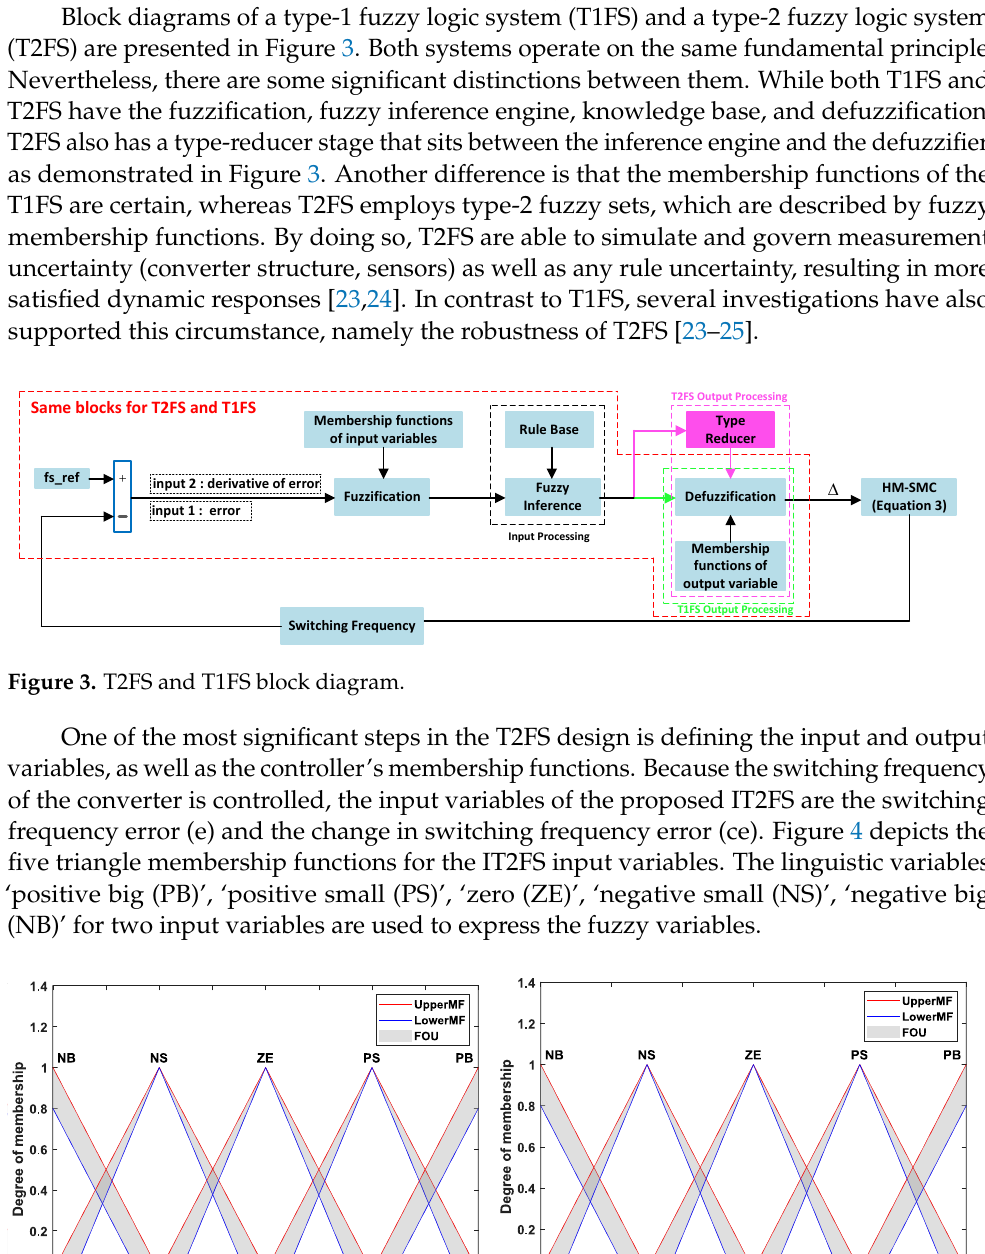
Figure 4. IT2FS membership functions for input variables. The hysteresis band ( ∆ ) is the output variable of the IT2FS. Five triangle membership functions, which are expressed by the linguistic variables ‘negative big (NB)’, ‘negative small (NS)’, ‘zero (ZE)’, ‘positive small (PS)’, and ‘positive big (PB)’, are determined for the output variable of the IT2FS, as seen in Figure 5. The rules are developed using